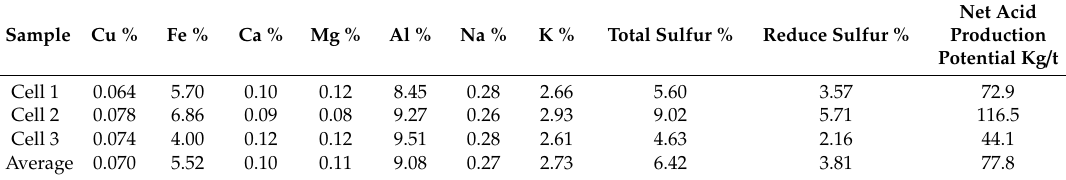
Table 2. Characteristics of the heap bioleaching